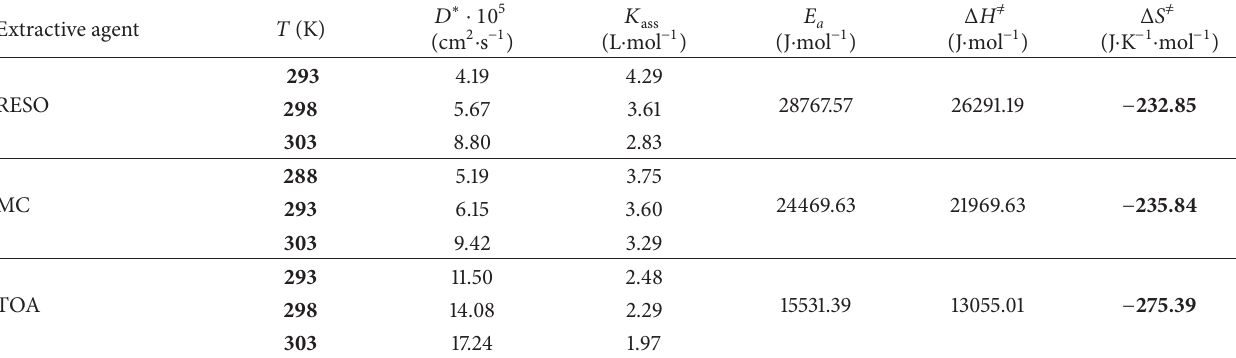
, Δ𝐻 ̸= , and Δ𝑆 ̸= for facilitated extraction process of a